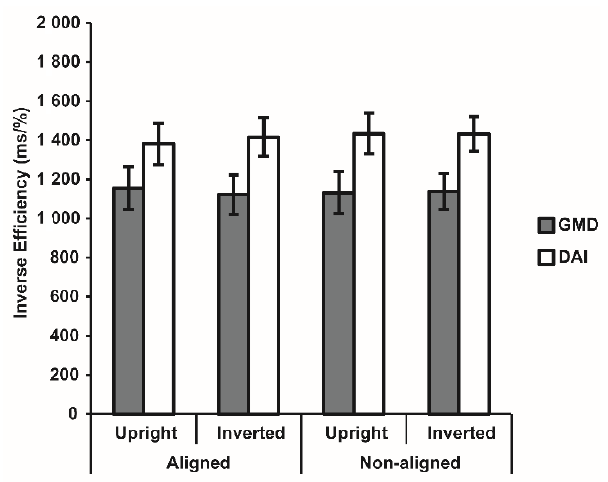
Figure 3. Inverse effect (IE) for each condition of the Visual Body Recognition task for the two clinical groups. Note. Bars indicate Standard Error of the Mean of measurements of 16 same-response trials in six blocks (N = 96) for 16 participants with grey matter damage (GMD) and 17 participants with diffuse axonal injury (DAI).